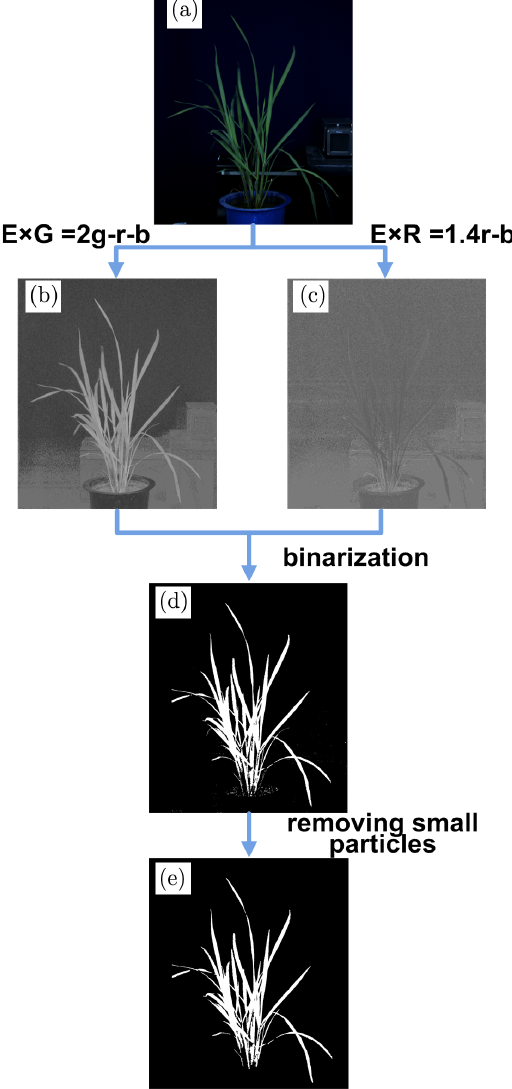
Fig. 2. Outline of the side-view image processing procedure. (a) The original image; (b) the E (cid:2) G image; (c) the E (cid:2) R image; (d) the binary image; and (e) the result of removing small